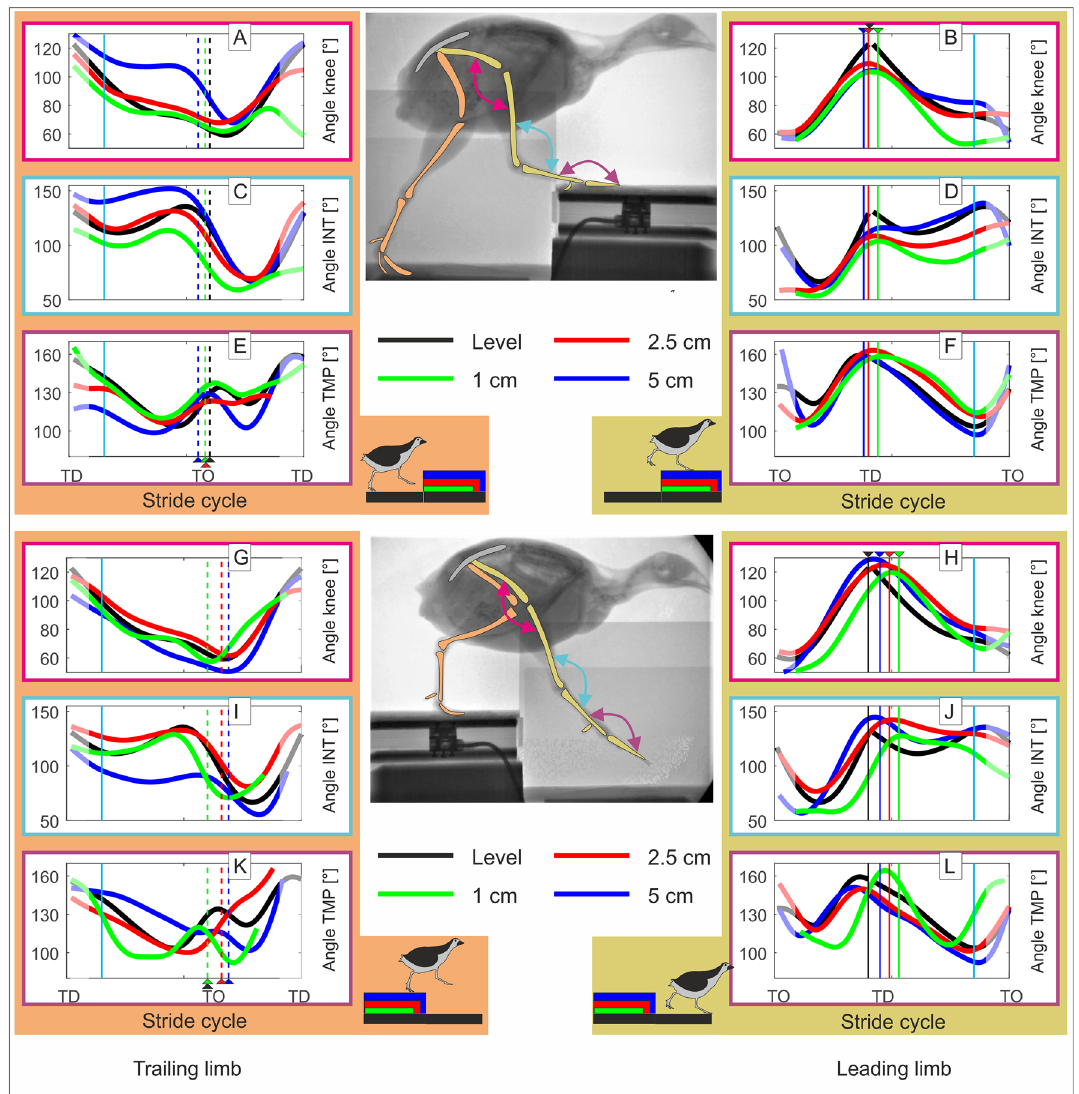
Figure 3. Joint angles. Level vs step-up (above): ( A , B ) knee; ( C , D ) intertarsal (INT); and ( E , F ) tarsometatarsal- phalangeal (TMP). Level vs drop (below): ( G , H ) knee; ( I , J ) INT; and ( K , L ) TMP. Left: trailing leg stepping before the step up/downwards (stride i-1), right: leading leg stepping after the step up/downwards (stride i). Curves display mean values of joint angles during level (black) and step locomotion (1 cm: green, 2.5 cm: red, 5 cm: blue) in the quail. Black, blue, red, green dashed lines indicate toe-off (TO), while solid lines touch down (TD). Cyan solid lines indicate 15% and 85% of the stride. Due to the constrained field of view in the X-ray fluoroscope, hip data was often missing at the beginning and at the end of the stride cycles and average values might be less reliable (showed